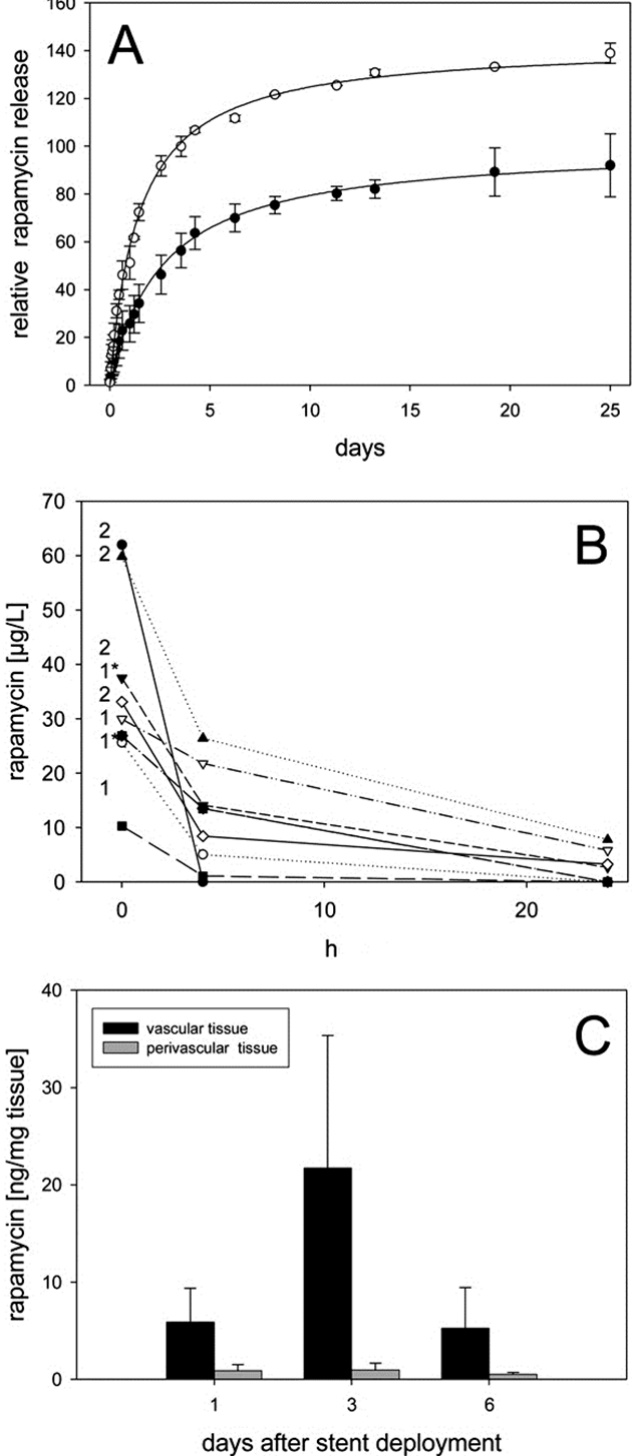
Figure 7. Pharmaco kinetics of rapamycin-coated microporous stents. ( A ) HPLC-based cumulative rapamycin release kinetics from single-coated and dual-coated stent; ( B ) High-performance liquid chromatography (HPLC)-measured rapamycin blood levels in 8 pigs receiving either 1 or 2 single-coated rapamycin-eluting microporous stents (number on the left of the diagram); and ( C ) Maximum tissue levels in the vascular and perivascular wall. (Reprinted with permission from [66]. Copyright 2005 Wolters Kluwer